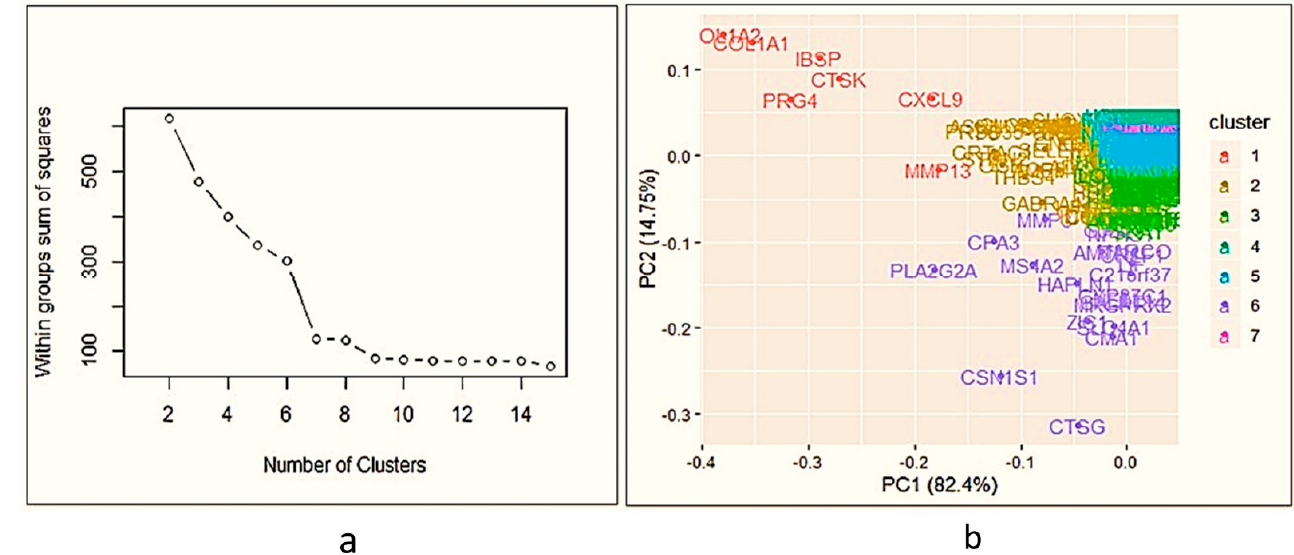
Figure 2. Cluster analysis of differential gene expression between osteophyte and control samples.